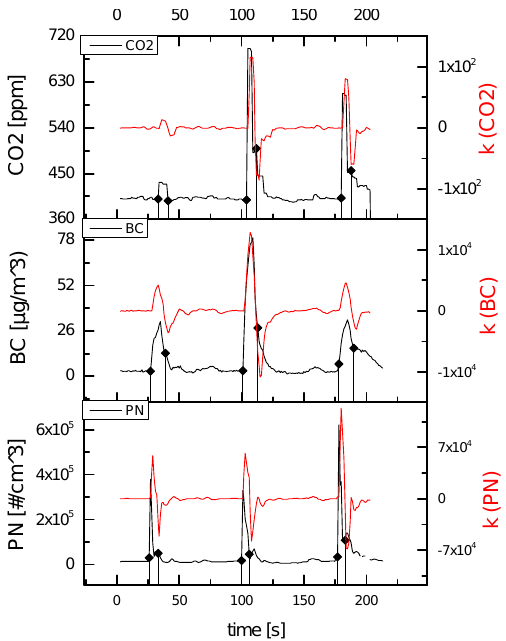
Figure 1. Examples of three consecutive stationary plume measure- ments. Marked with black dots and drop lines are the beginning and the end of each plume. The calculated slope ( k ) of each pollutant which was used to determine the end of the plume is plotted in red.